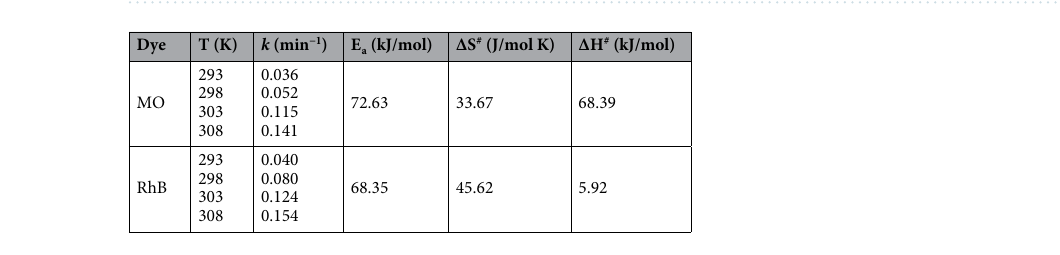
Table 1. The values of thermodynamic and kinetic parameters of reduction reaction of MO and RhB dyes in the presence of the SGCN/Fe 3 O 4 /PVIs/Pd